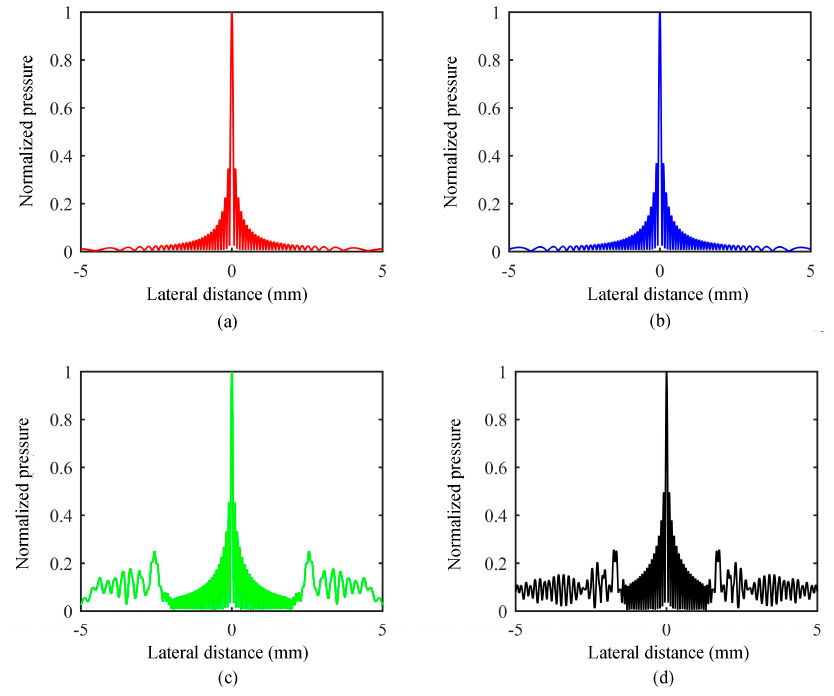
Figure 7. The lateral sound field of the phased array with different element pitches of 60 µ m ( a ), 70 µ m ( b ), 120 µ m ( c ), and 160 µ m ( d ).